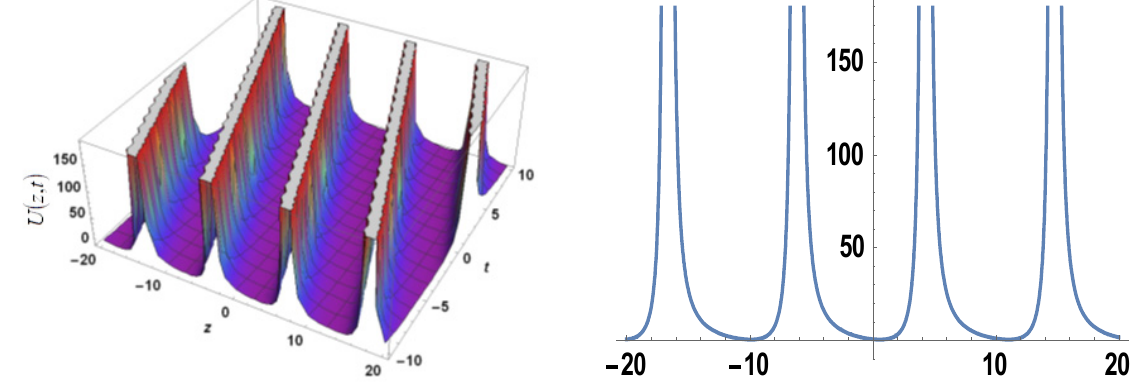
Figure 6. The 3D and 2D plots of Equation (56) for various values of parameters.